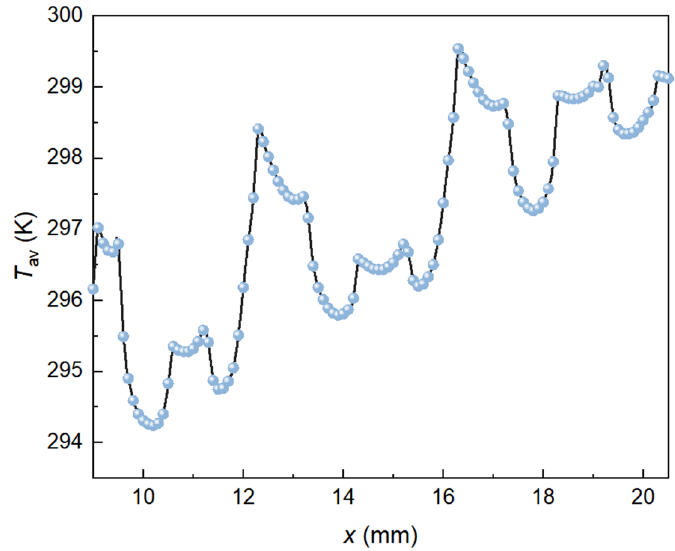
Figure A6. Variation of the temperature average on the x location.